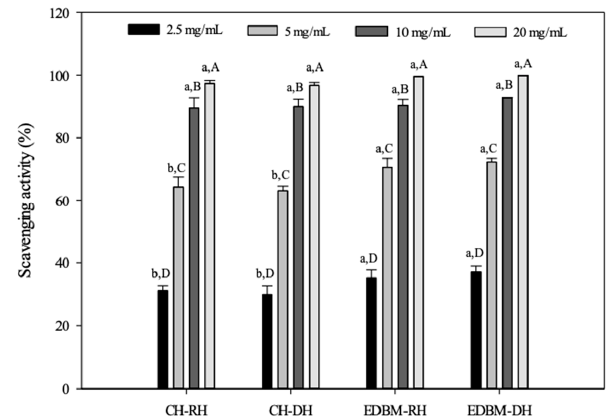
Figure 6. ABTS scavenging activities of bovine hemoglobin hydrolysates in CH ‐ RH, CH ‐ DH, EDBM ‐ RH and EDBM ‐ DH at different concentrations. Values with different lowercase letters (a,b) within the same concentration are significantly different; values with different capital letters (A–D) within the same condition are significantly different ( p < 0.05, Tukey test). Trolox was used as a reference molecule. The comparative IC 50 and the relative values expressed as TEAC are reported in Table 5. To inhibit 50% of ABTS radicals, concentra ‐ tions of hemoglobin hydrolysates between 3.43 and 4 mg/mL were needed. Statistical analysis showed that there was a significant difference ( p < 0.05) for IC 50 for bovine hemo ‐ globin hydrolysates between all conditions even if the values were very similar. To inhibit 50% of ABTS radicals, a concentration of 0.56 mg/mL of NKT was needed; this value is very close to Trolox but is statistically different ( p < 0.05). Regarding TEAC, the ABTS